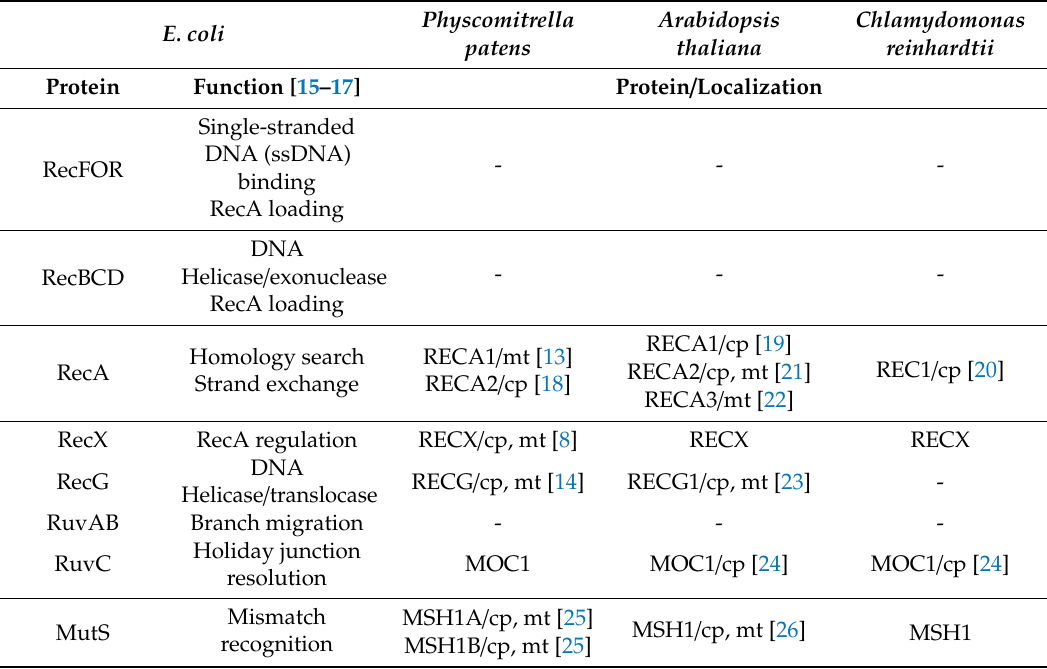
Table 1. Summary of homologous recombination repair (HRR) factors and MutS homolog 1 (MSH1) in Escherichia coli and their plant